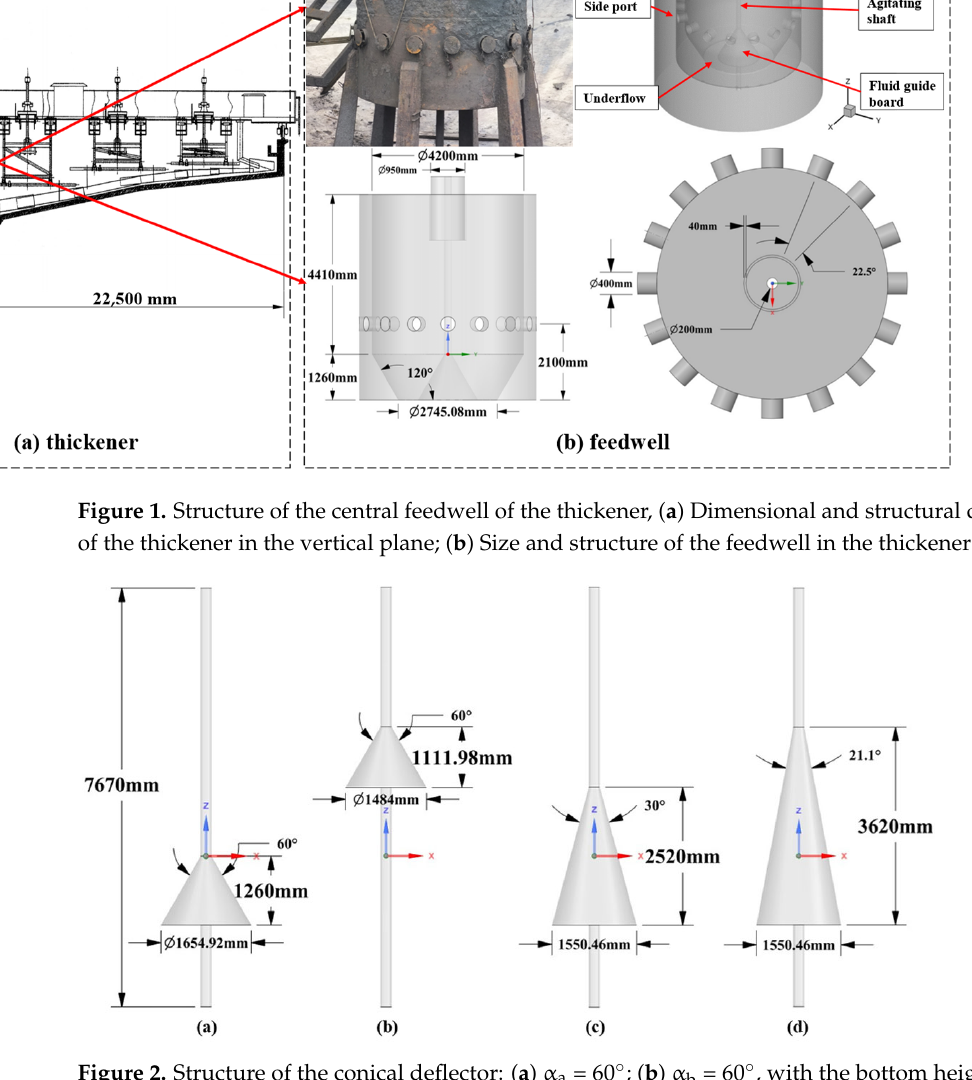
Figure 2. Structure of the conical deflector: ( a ) α a = 60°; ( b ) α b = 60°, with the bottom height of the conical deflector of ( b ) being 1766 mm higher than that of ( a ); ( c ) α c = 30°; and ( d ) α d = 21.1°.